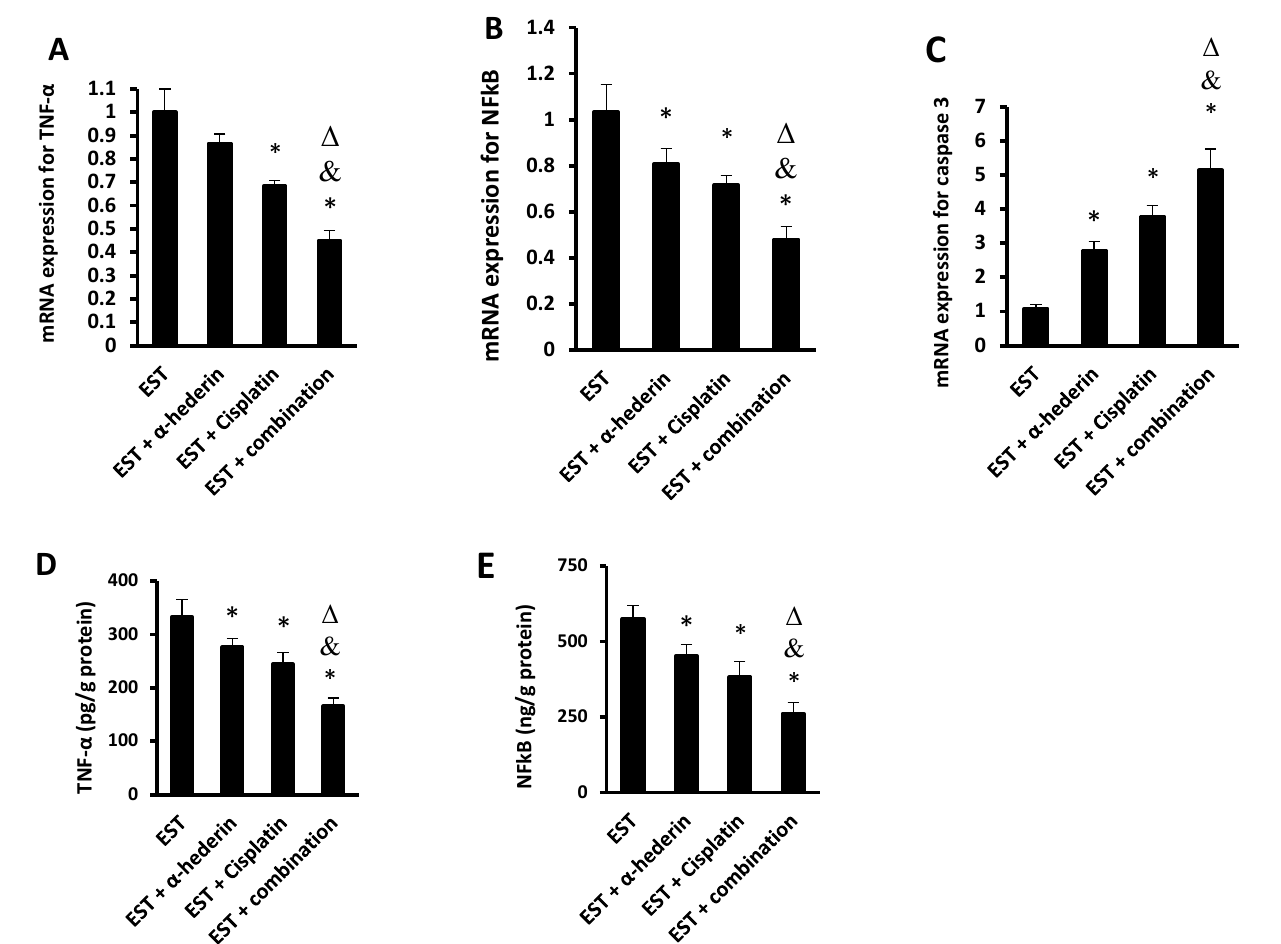
Figure 2. RT-PCR and protein level for tumor markers. The mRNA expression folds for ( A ) TNF- α , ( B ) NF κ B, and ( C ) caspase 3 and protein level of ( D ) TNF- α , ( E ) NF κ B. *: versus EST control, &: versus EST + α -hederin group, ∆ : versus EST + cisplatin group. Data are mean ± SD and statistical analyzed at p < 0.05.